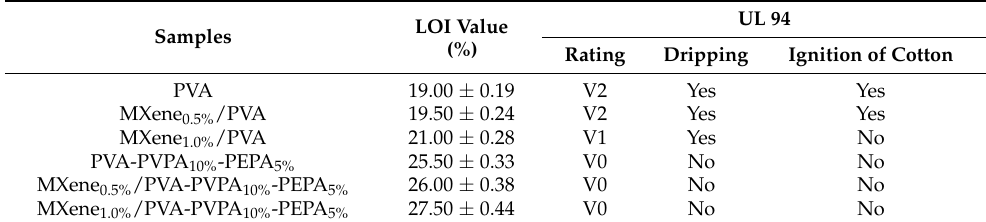
Table 2. LOI and UL94 test results of PVA and MXene/PVA nanocomposites.